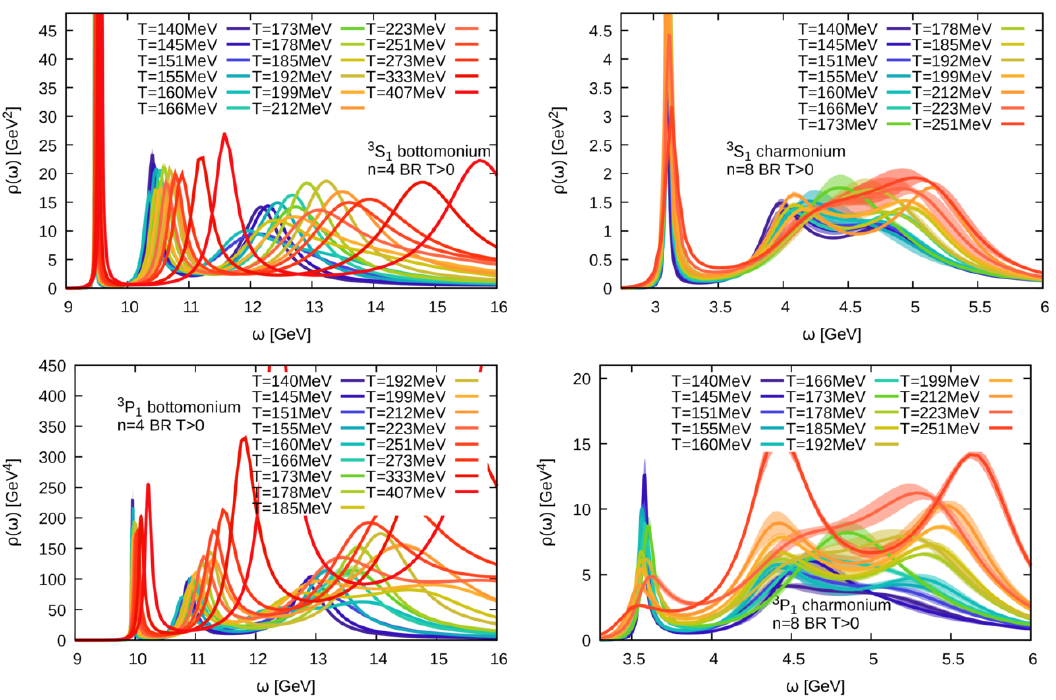
Figure 19 . Finite temperature bottomonium (left) and charmonium (right) spectral functions reconstructed using the BR method. The top row contains the spectral functions in the 3 S 1 channel, while the bottom row features the 3 P 1 channel.